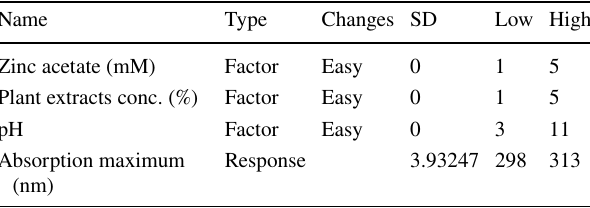
Table 1 The experimental levels of factors used for RSM-BBD opti- mization